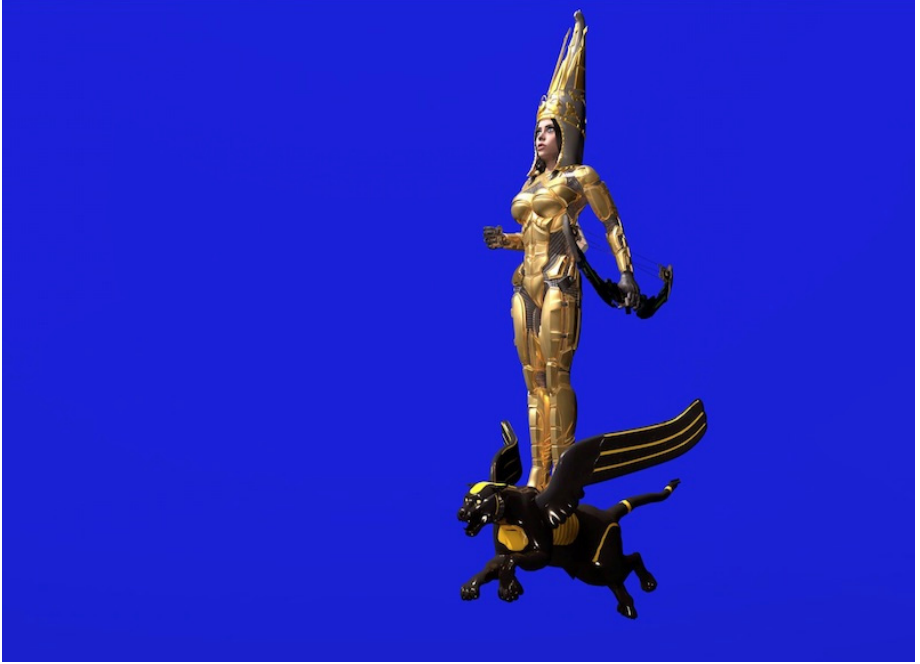
Figure 9. Anvar Murepov, video still from The Golden Woman (2018). Image courtesy of the